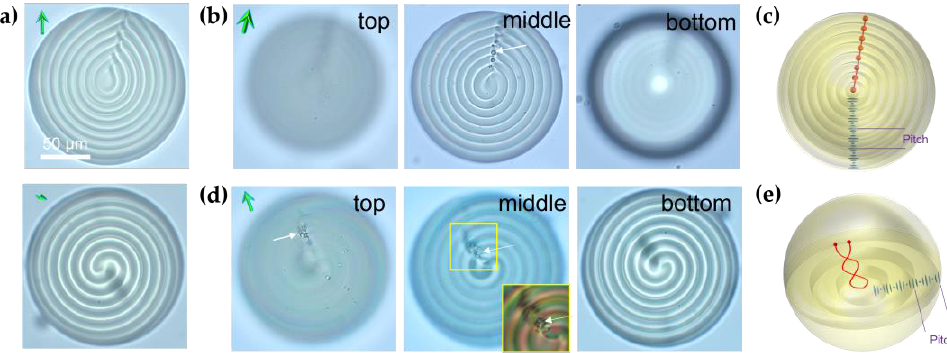
Figure 7. Laser processing of a CLC droplet with bulk defect line. ( a ) The microscopic texture of CLC droplets with N = 15.6. With different orientations of the helical axis (green axis in 3D), it changed from nesting cups (up image) to a double spiral (bottom image). ( b , d ) The injected NDs organized into two different assembles in the host CLC droplet with the same chirality. The three images correspond with different focal planes of the microscope. ( c , e ) Schematics for the geometry of bulk defect line based on the structure of the ND assembly in ( b ) and ( d ), respectively. The 3D green arrow indicates the helical axis of the CLC droplet.